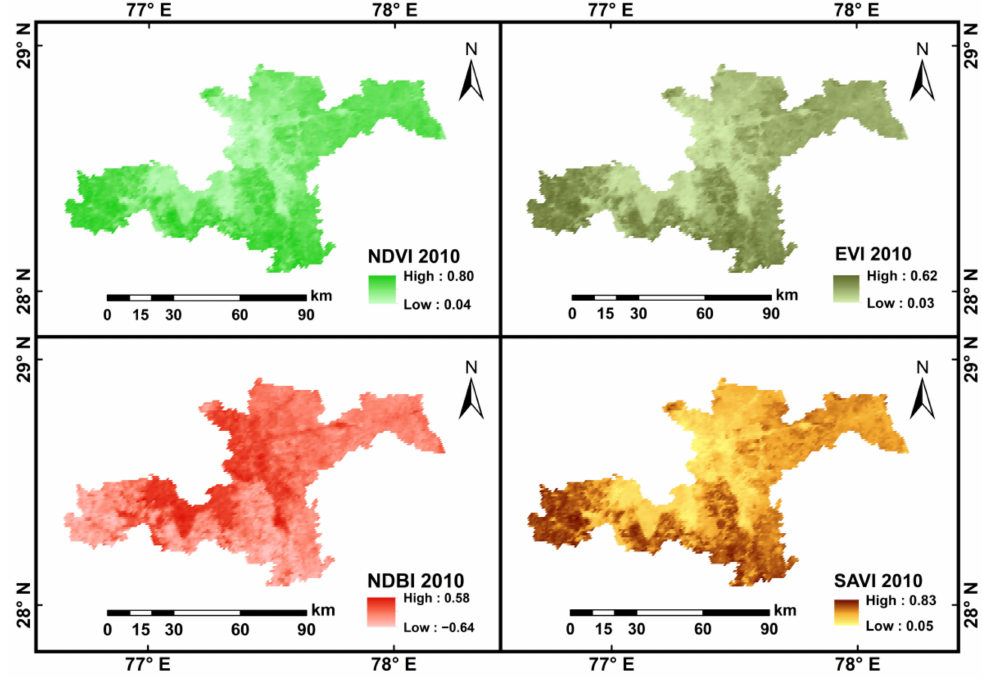
Figure 5. Maps of NDVI, NDBI, EVI, and SAVI of Aqua MODIS 2010.